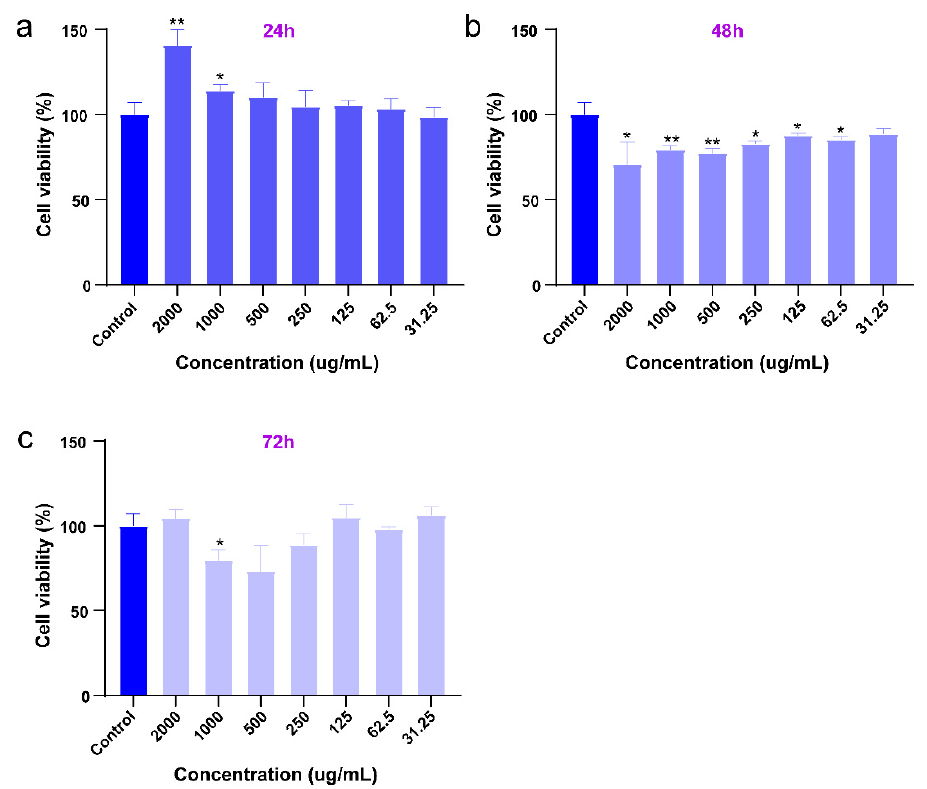
Figure 5. Viability of 4T1 cells incubated with CaF 2 :Y,Gd,Nd NPs at increasing concentrations (0–2 mg/mL) after ( a ) 24; ( b ) 48; and ( c ) 72 h assessed by MTS assay. All data are expressed as mean ± SD from three independent experiments. Statistical significance was calculated using the t -test, by com- paring experimental groups to the control group (* p < 0.05, ** p < 0.01). CaF 2 :Y,Gd,Nd NPs’ optical characteristics partially overlap with the excitation and